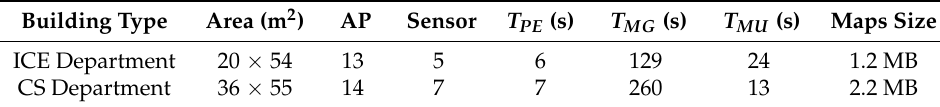
Table 2. Statistics of area of sites, AP; number of access points, Sensor; number of sensors, T PE ; parameter estimation time, T MG ; metadata generation time, T MU ; map update time on sensor feedback and Map Size; map file size in